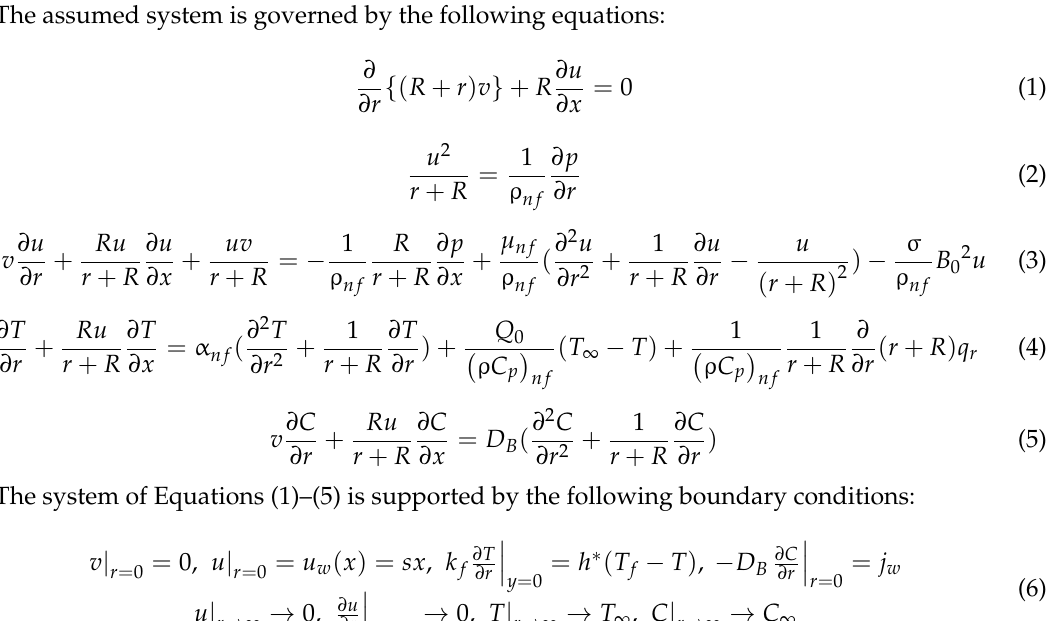
Figure 1. Flow geometry.